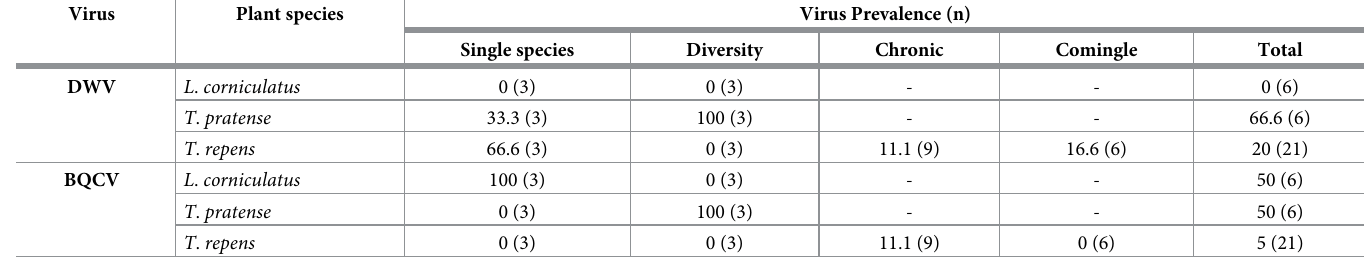
Table 1. Summary table showing the prevalence of deformed wing virus (DWV) and black queen cell virus (BQCV) on three plant species across all foraging trials where both honey bees and bumble bees foraged. Plants foraged by bumble bees only were all negative for viruses and are therefore excluded from this table. Virus preva- lence is reported as the number of flower samples with virus detected divided by the total number of flower samples tested for each trial (n) multiplied by 100. Total column provides the virus prevalence for each plant species across all